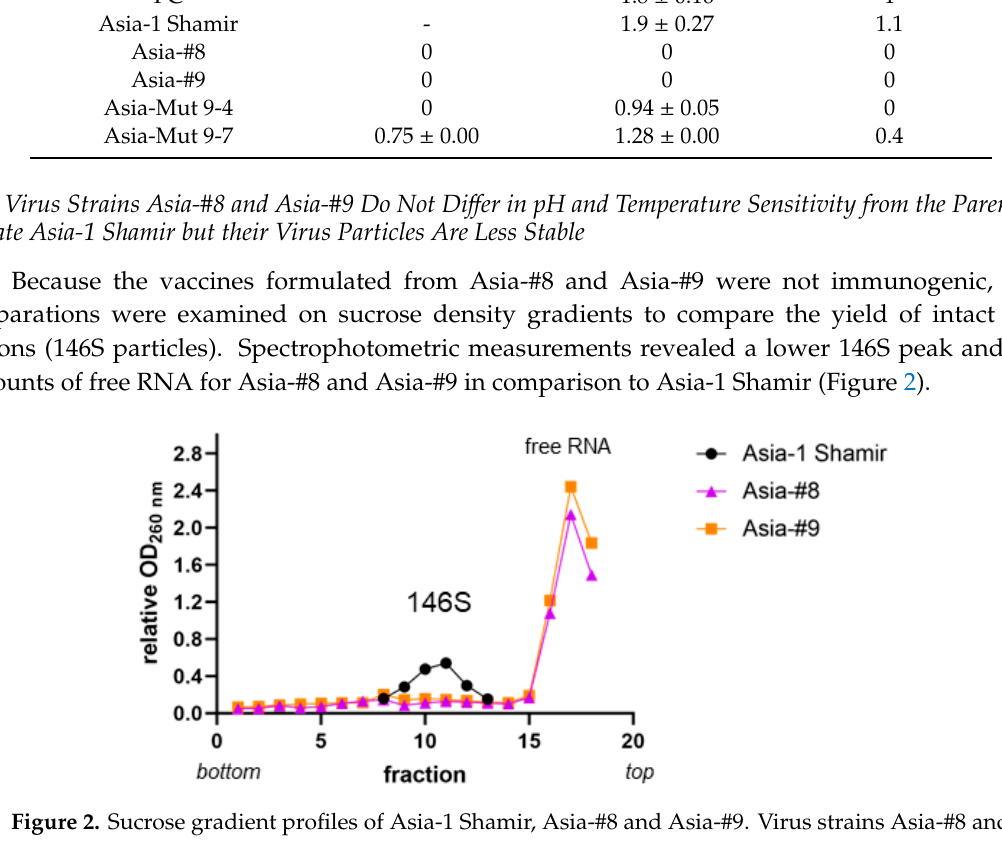
Table 6. Virus neutralization titers for the vaccine candidates and the corresponding r 1 -values relative to the PC.